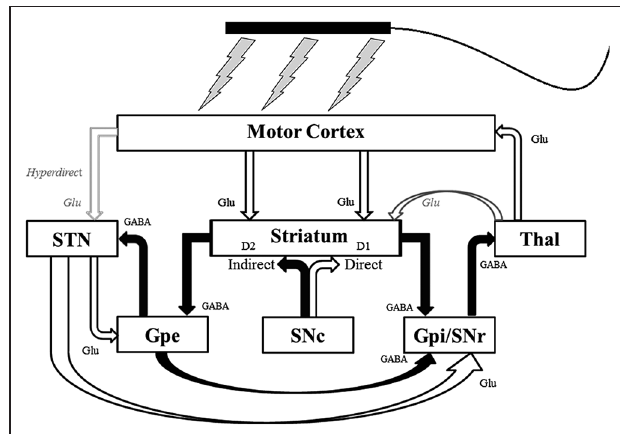
FIGURE 1 | Schematic of the pathways of the basal ganglia-thalamocortical network that non-invasive transcranial electrical stimulation could potentially influence . Unfilled arrows are excitatory connections. Filled arrows are inhibitory connections. D1 = D1 dopaminergic receptors; D2 = D2 dopaminergic receptors; GABA = γ -Aminobutyric acid (GABA)-ergic; Glu = glutaminergic; Gpe = external segment of the globus pallidus; Gpi = internal segment of the globus pallidus; SNc = substantia nigra pars compacta; SNr = substantia nigra pars reticulata; STN = subthalamic nucleus; Thal = thalamus. Modified with permission from Hess et al.